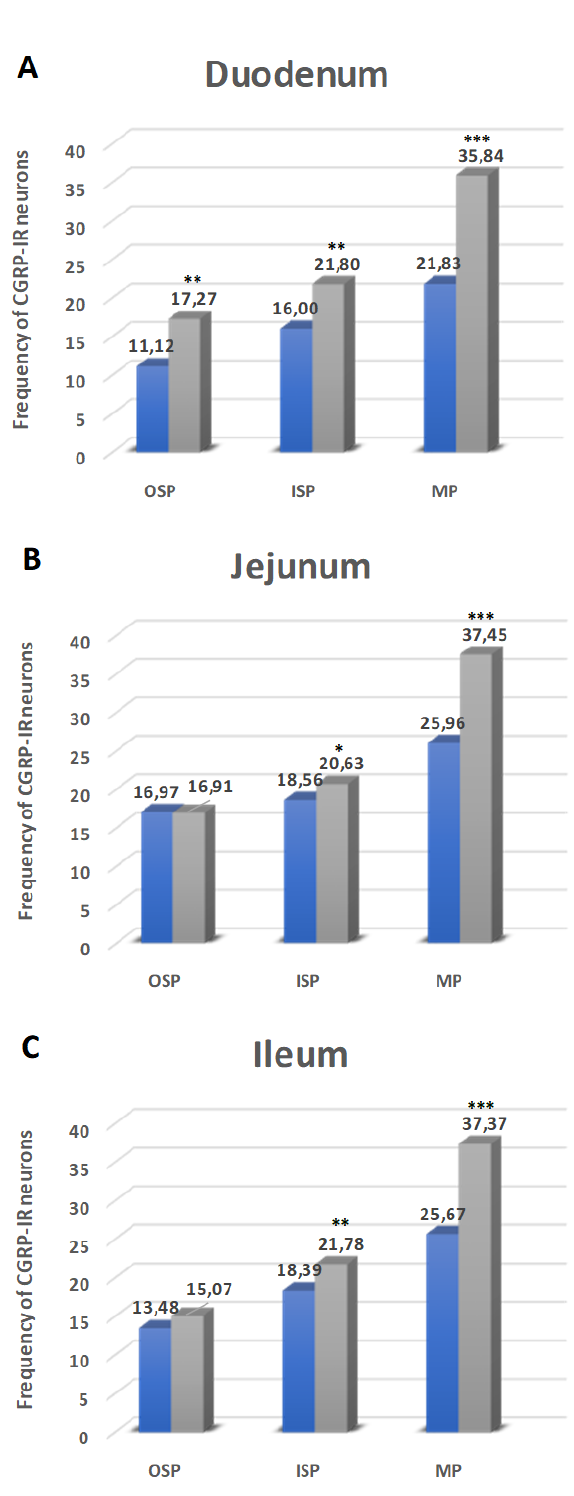
Figure 7. Schematic diagram of the numbers of perikarya immunoreactive to calcitonin gene-related peptide (CGRP) ( A–C ) of the control (blue bars) and experimental group (grey bars) in the particular parts of the small intestine. OSP – outer submucosal plexus, ISP – inner submucosal plexus, MP – myenteric plexus. * p < 0.05, ** p < 0.01, *** p < 0.001 – indicate differences between all groups for the same neuronal populations.